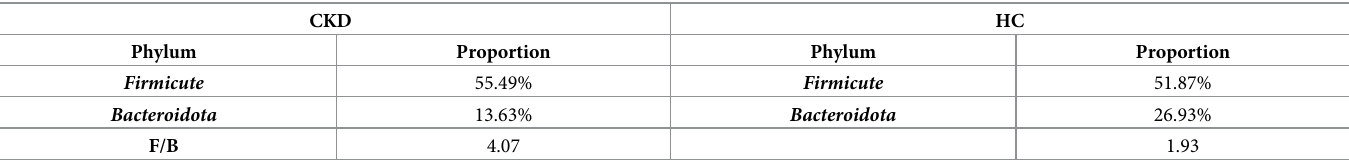
Table 1. F/B ratio in CKD and HC